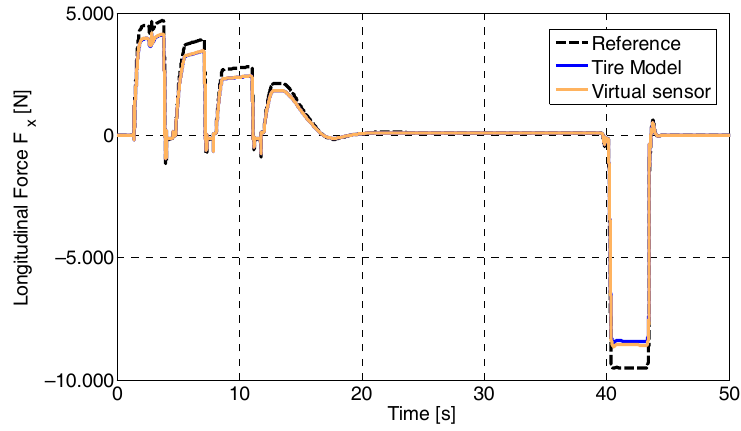
Figure 12. The chassis longitudinal force predicted from the tire model and virtually measured compared to the simulated profile.